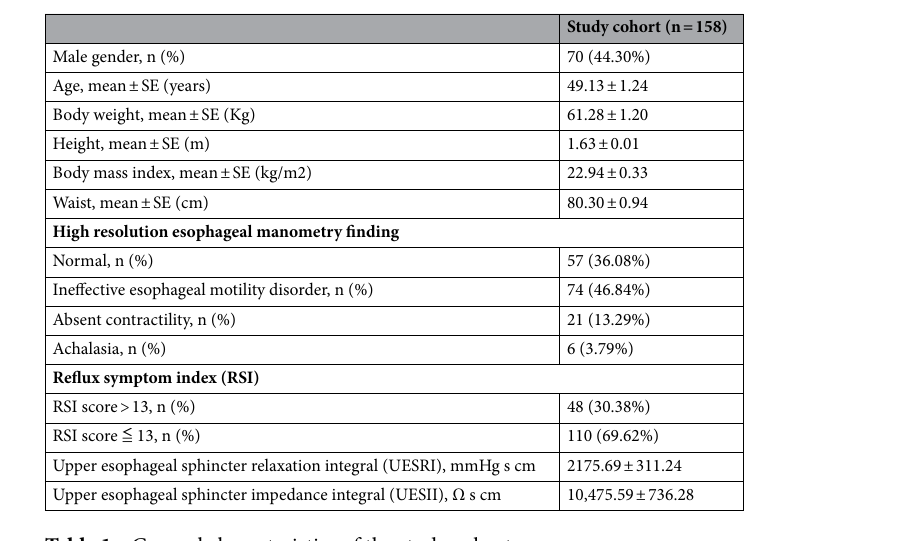
Table 1. General characteristics of the study